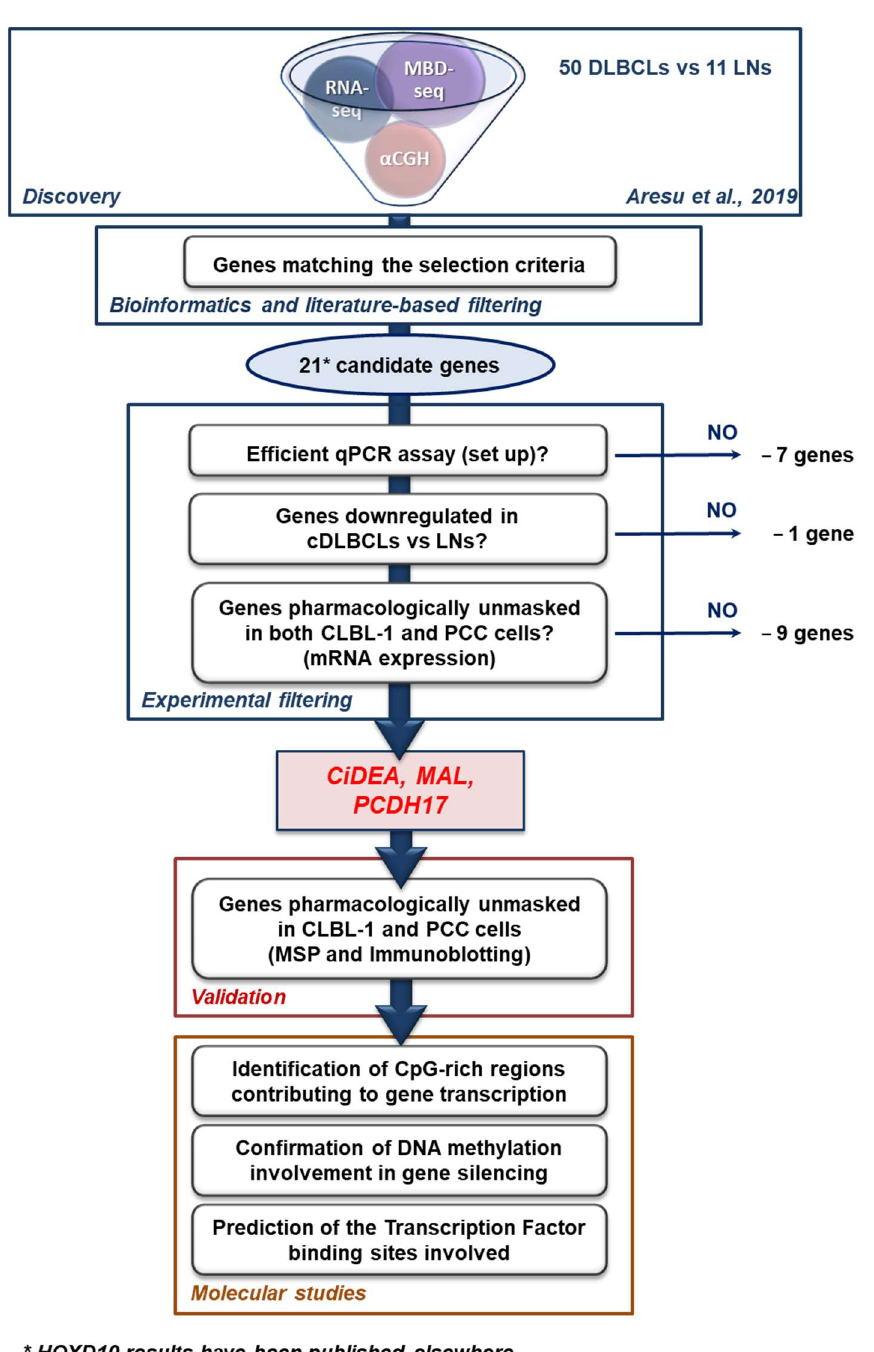
Figure 1. Flow chart of the